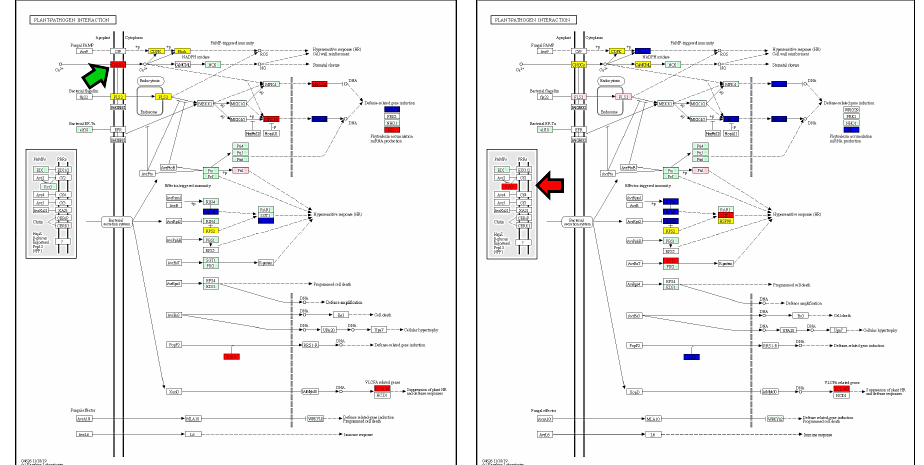
Figure 3. KEGG enrichment pathway: MAPK signaling pathway-plant. The red and blue boxes rep- resent genes that are upregulated and downregulated, respectively. The yellow boxes represent genes that are both upregulated and downregulated. The red frames indicate MAPKKK, MAKK, and MAPK genes, from left to right. The blue frames indicate pathways with reduced expression. The red arrows indicate the upregulated OXI1 gene. The green arrows show the upregulated RbohD gene. Black solid arrows indicate stimulation/activation. Black dashed arrows indicate indirect ef- fect.